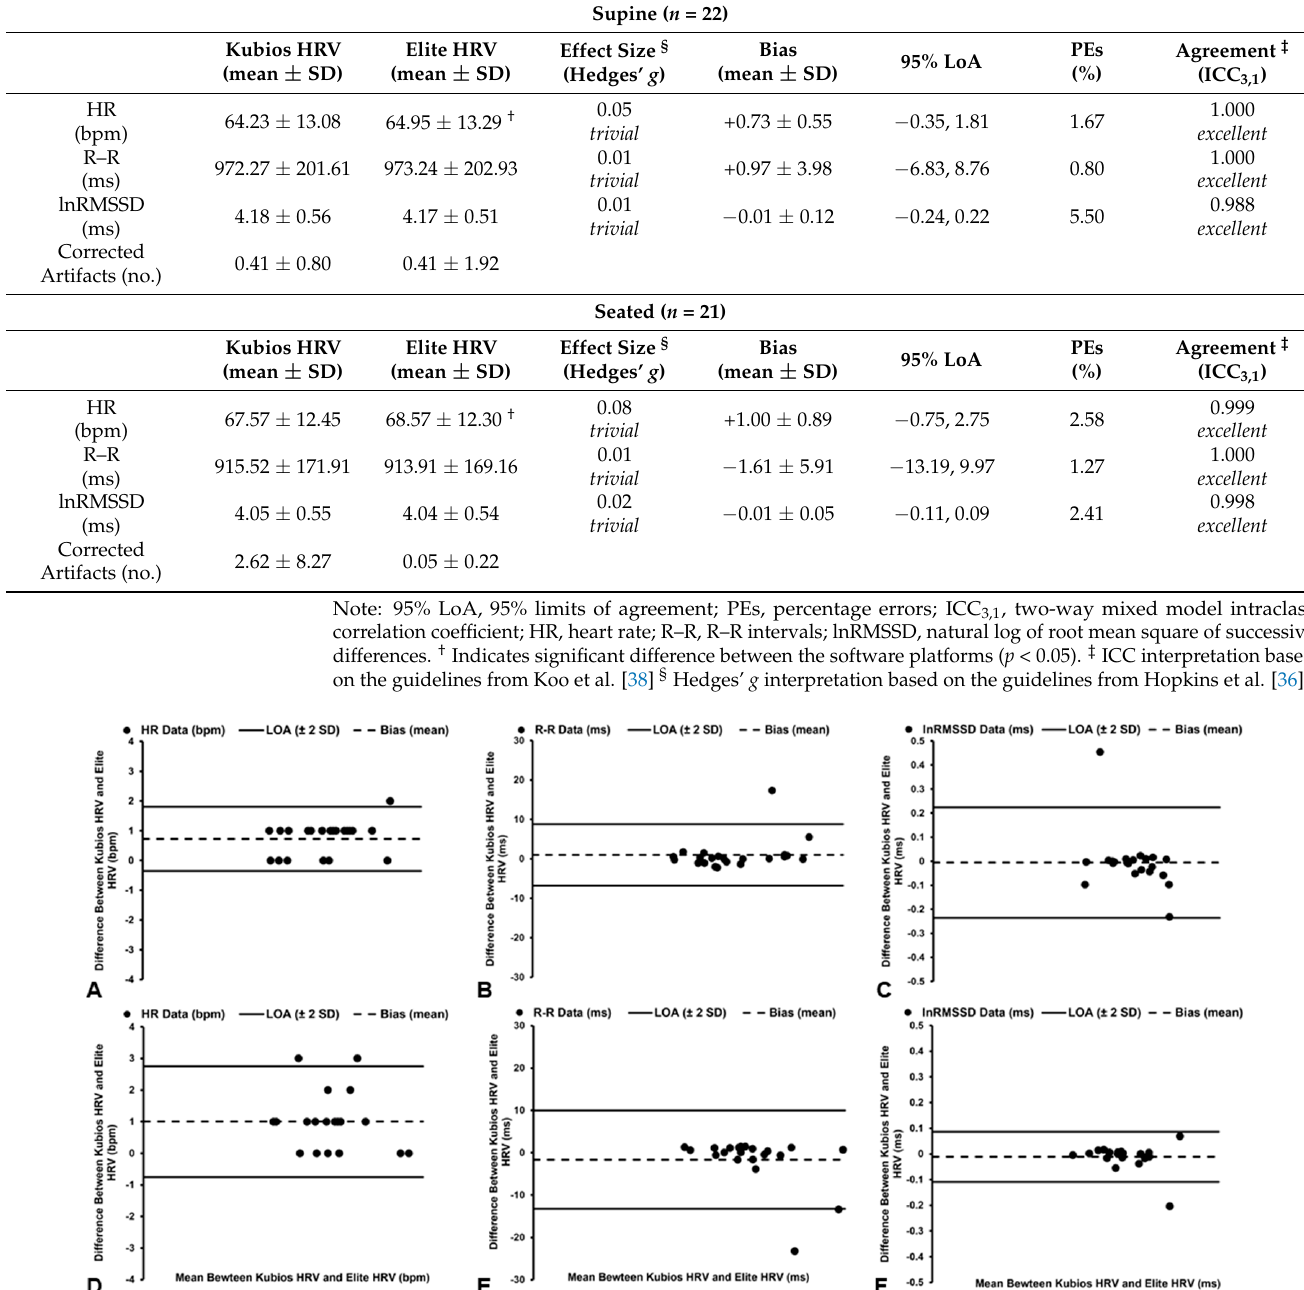
Trivial and nonsignificant ( t 21 = 0.244, p = 0.810) differences in lnRMSSD data were observed between the software platforms (Table 3), with the Elite HRV smartphone ap- plication demonstrating a mean bias of − 0.01 ms and 5.50% PEs (Figure 4C). Excellent agreement (ICC 3,1 = 0.988, [95% CI: 0.971, 0.995]) and a near-perfect relationship were